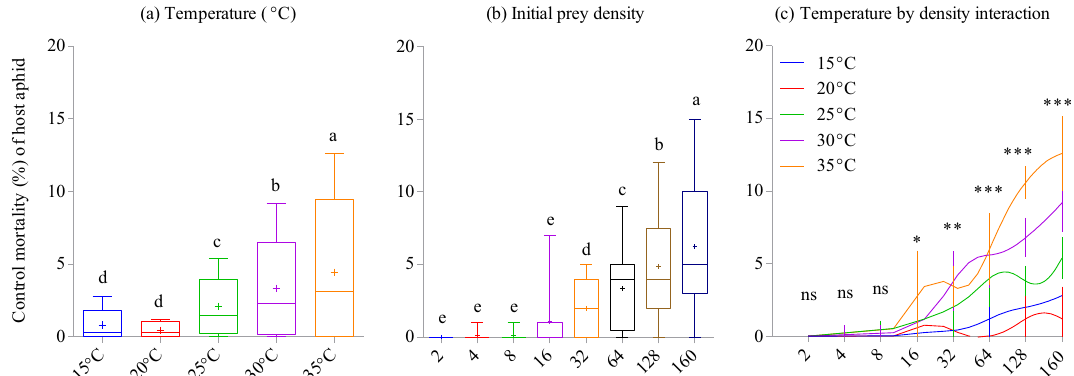
Figure 1. Percent control mortality of Acyrthosiphon pisum nymphs exposed to different thermal conditions under different prey densities. Data are expressed with box plots for temperature ( a ), prey density effects ( b ), and through line graphs for density-wise temperature effects ( c ) on mean percent mortalities (with 95% confidence intervals (CIs)) following significant temperature by density interaction. Box plots are showing the range of data (lower and upper quartiles and extreme values), median, and mean (symbols), and different alphabets indicate significant differences between group means ( P < 0.05; Tukey’s HSD test). In panel c, the temperature effects are tested within each prey density offered through running independent ANOVAs and significant means are compared according to non-overlapping 95% CI of difference. Symbols ‘*’, ‘**’, and ‘***’ denote significance at 0.05, 0.01, and 0.001 levels, respectively, whereas ‘ns’ indicates non-significant ( P > 0.05) differences for ANOVAs performed.